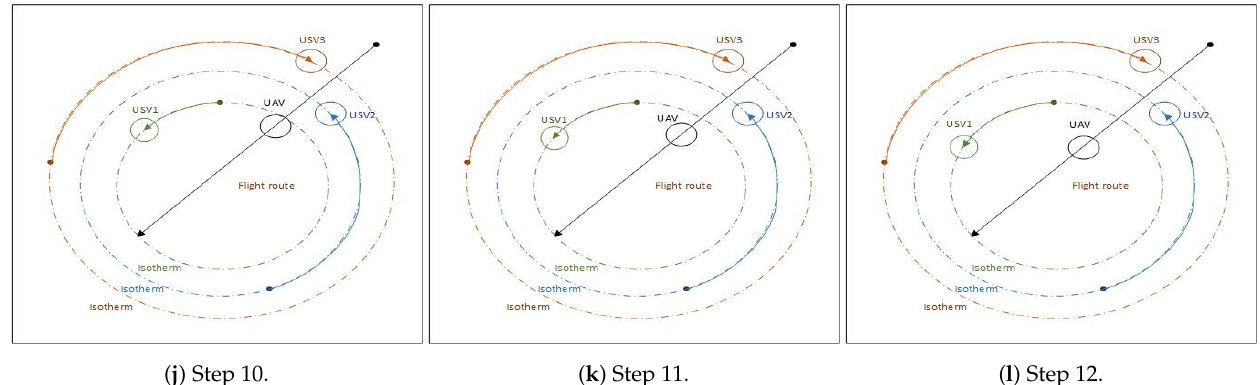
Figure A1. Experiment of cooperative control algorithm process without noise (Step 1–Step 12).